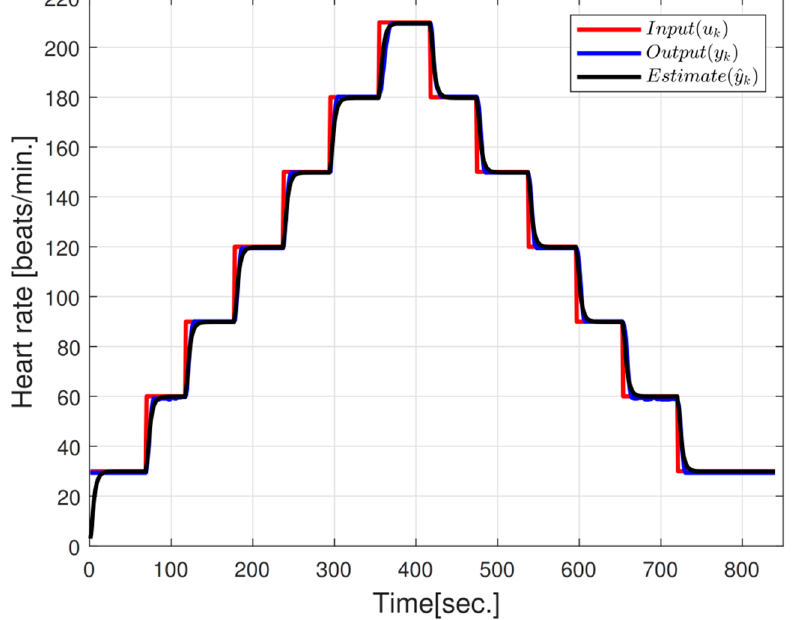
Figure 8. Fetal monitor model simulation results.